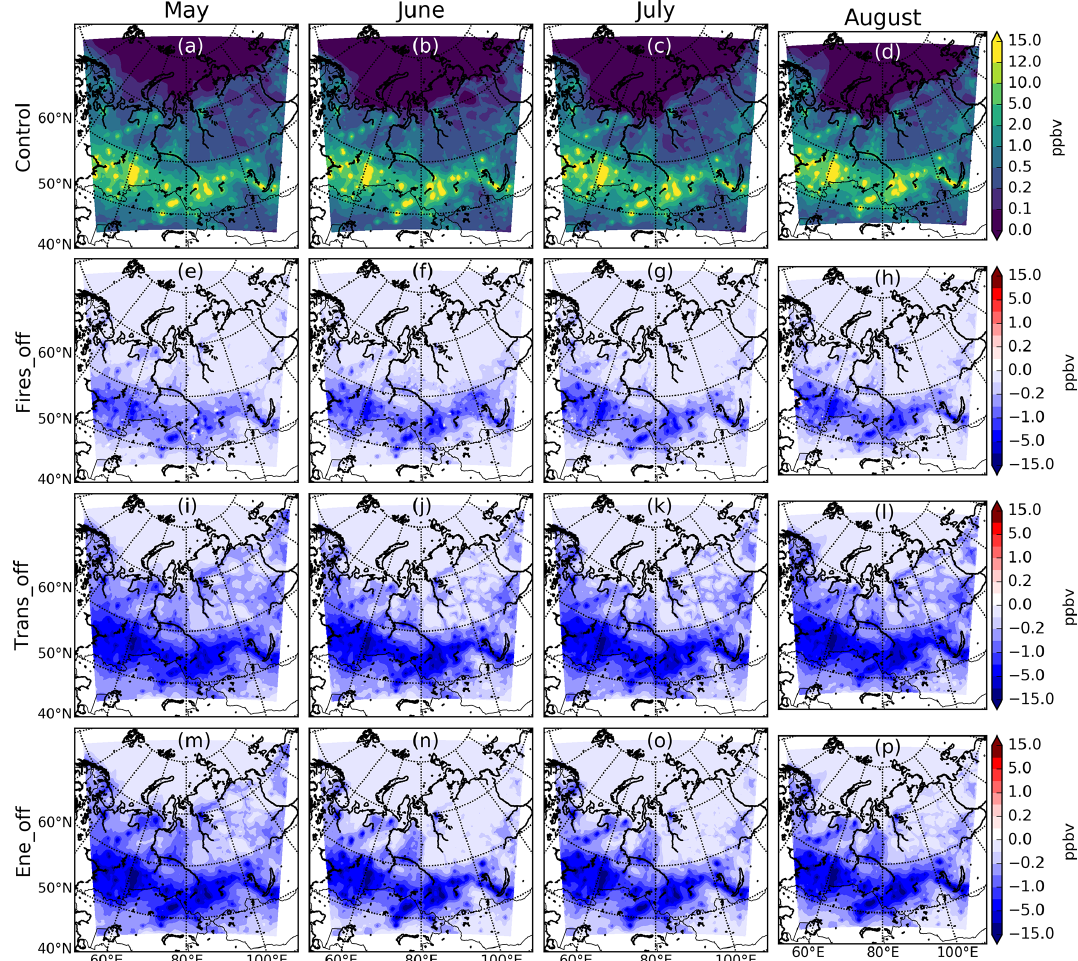
Figure 7. Simulated control and sensitivity run changes in surface NO 2 concentrations. Panels (a) – (d) show monthly means of WRF-Chem surface NO 2 for May–August using ECL_SCALED emissions. Panels (e) – (h) show monthly means of WRF-Chem surface NO 2 with all fire emissions switched off in domain (fires_off simulation) minus control simulation for May–August. Panels (i) – (l) show monthly means of WRF-Chem surface NO 2 with all transport emissions switched off in domain (trans_off) minus control simulation for May–August. Panels (m) – (p) show monthly means of WRF-Chem surface NO 2 with all energy emissions switched off in domain (ene_off) minus control simulation for